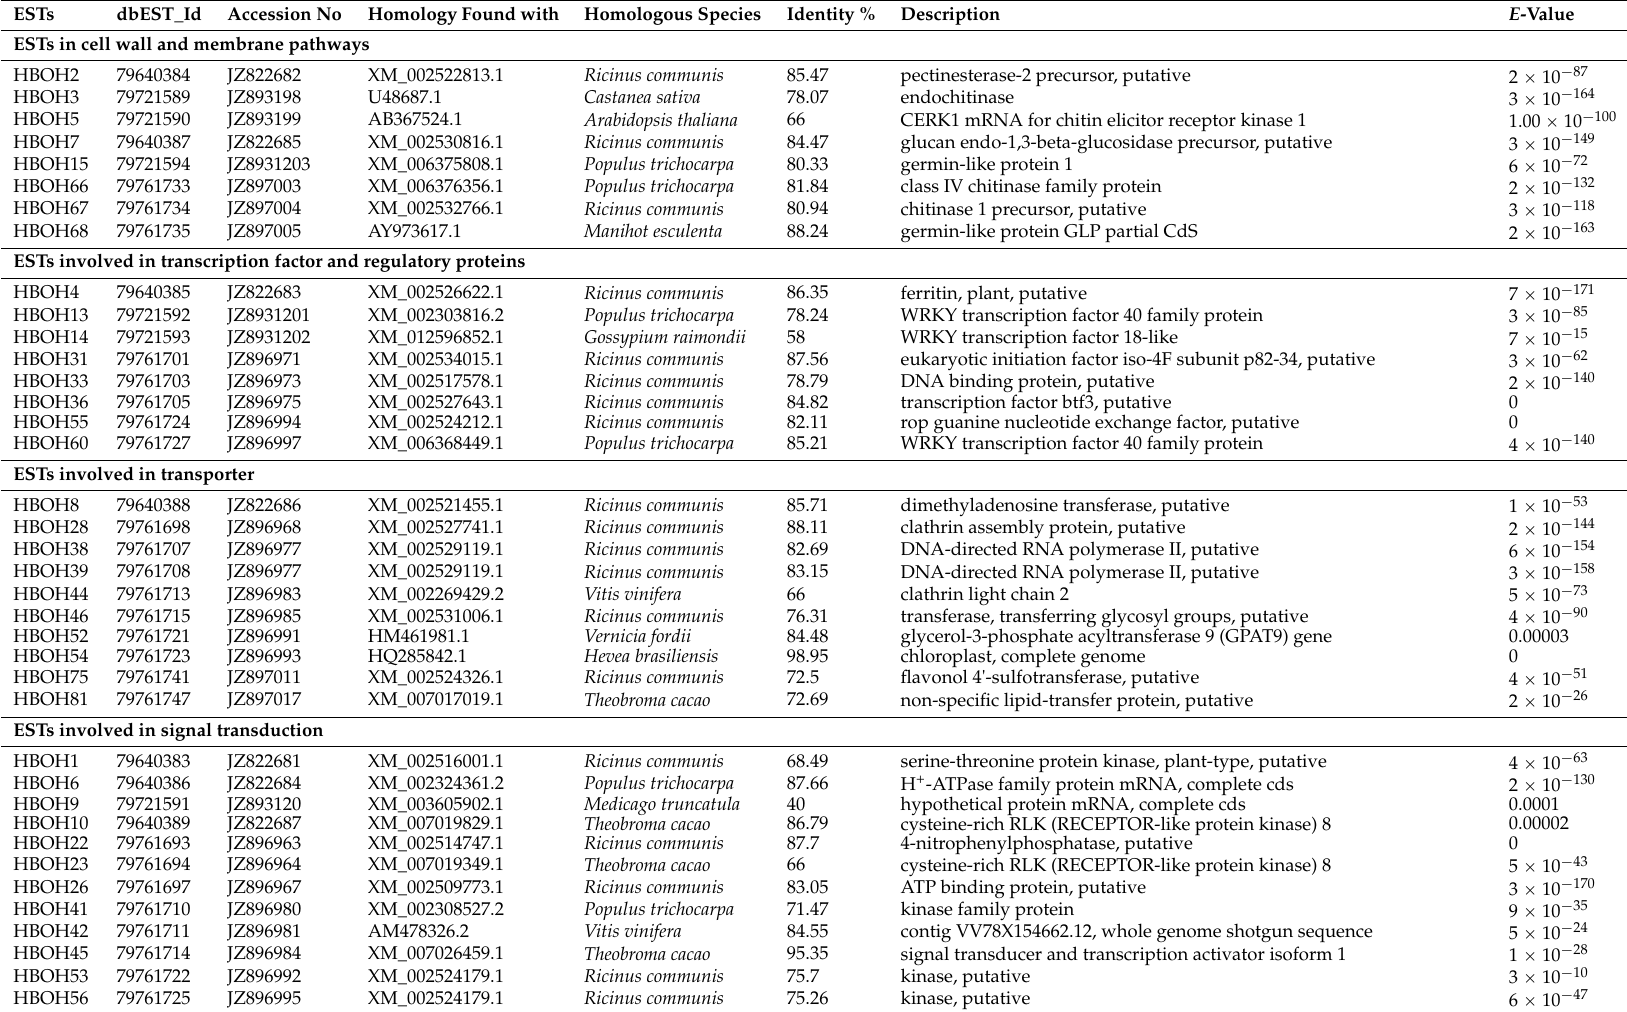
Table 1. List of ESTs differentially expressed in the resistant RRIC52 following O. heveae infection and their similarity to known proteins determined by BLAST